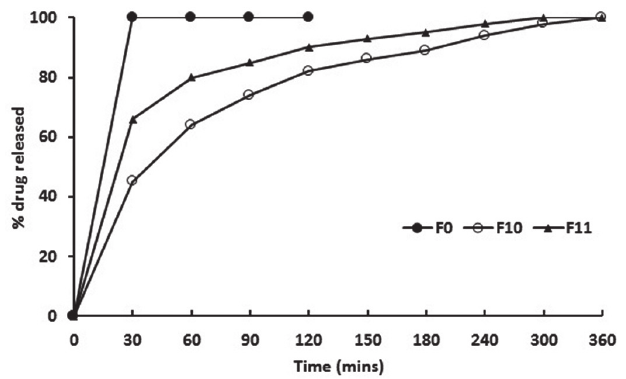
FIGURE 7 ‑ In vitro release profiles of DM from pellets formulations F10 and F11 compared to